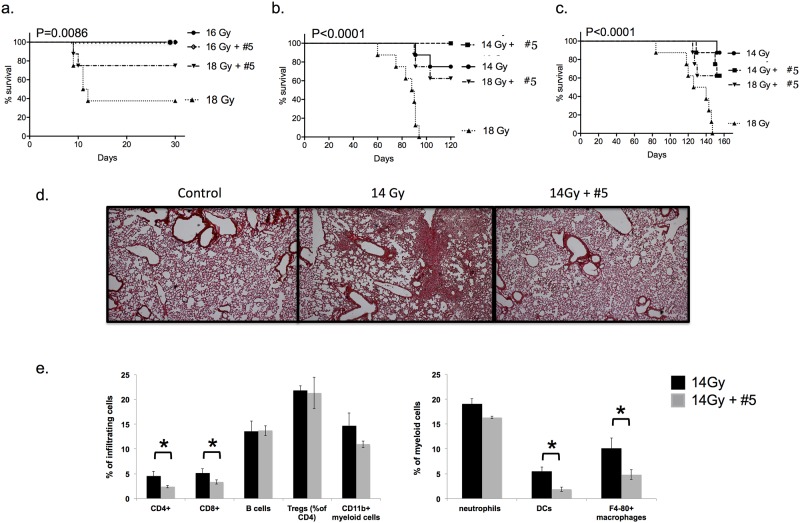
Intestinal and lung damage following radiation exposure can be significantly improved with 4-nitrophenylsulfonamides.(a) Compound #5 (5mg/kg daily x5 s.c.) mitigates lethality from intestinal ARS following 18Gy local abdominal irradiation. (b) Compound #5 (5mg/kg daily x5 s.c.) mitigates lethality from radiation-induced pneumonitis in C3H mice after 18 and 14Gy LTI. (c) Compound #5 (5mg/kg daily x5 s.c.) mitigates lethality from radiation-induced fibrosis in C57Bl/6 mice following 18Gy LTI. Note the differences in time to lethality for these endpoints. Kaplan-Meier with log rank statistics. (d) Picro Sirius Red staining of lungs of C57Bl/6 mice 156 days after LTI with (e) flow cytometric analysis of inflammatory infiltrate. (*p<0.05)